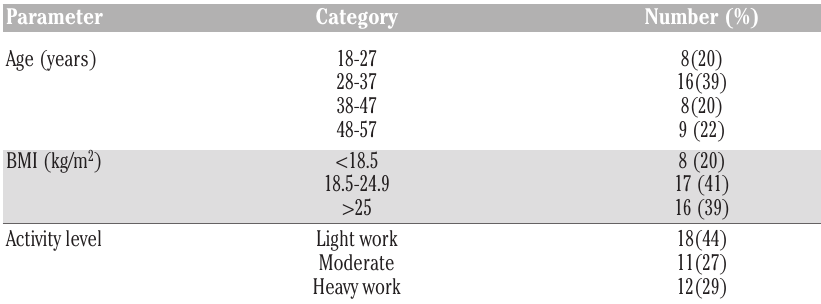
Table 1. Patients characteristics.